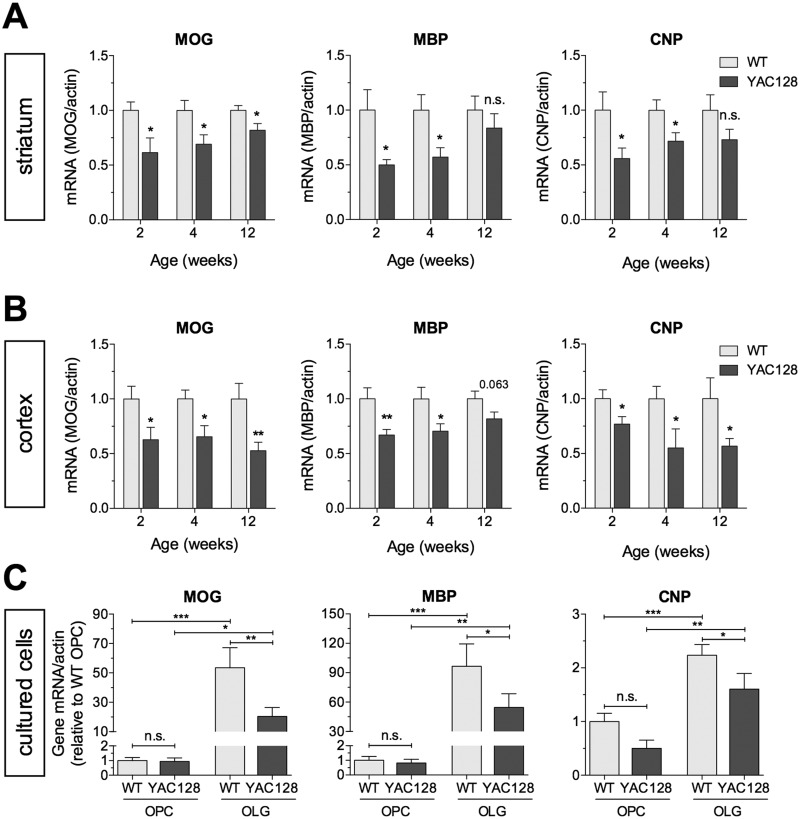
Reduced expression of myelin-related genes in YAC128 HD mice. Lower levels of mRNA transcript of MOG, MBP and CNP in the striatum (A) and cortex (B) of YAC128 HD mice at 2, 4 and 12 weeks of age compared with WT littermates (n = 6–10/genotype/time-point male mice). (C) mRNA transcript levels of MOG, MBP and CNP in OPCs immediately after isolation from P6–P7 YAC128 and WT littermate pups and after 7 days in oligodendrocyte differentiation media (n = 6–10). No significant differences were observed for any of the investigated transcripts in OPCs. After 7 days in oligodendrocyte differentiation media, a significant upregulation of MOG, MBP and CNP transcripts occurred in both WT and YAC128 mice, but the levels of transcripts for all three genes are significantly lower in YAC128 mice compared with those of WT littermates. All values were normalized to their respective beta-actin levels. (A–C) All values were normalized to their respective beta-actin levels. OPC, oligodendrocyte precursor cell; OLG, oligodendrocyte. * P < 0.05; ** P < 0.01; *** P < 0.001; n.s. = not significant.